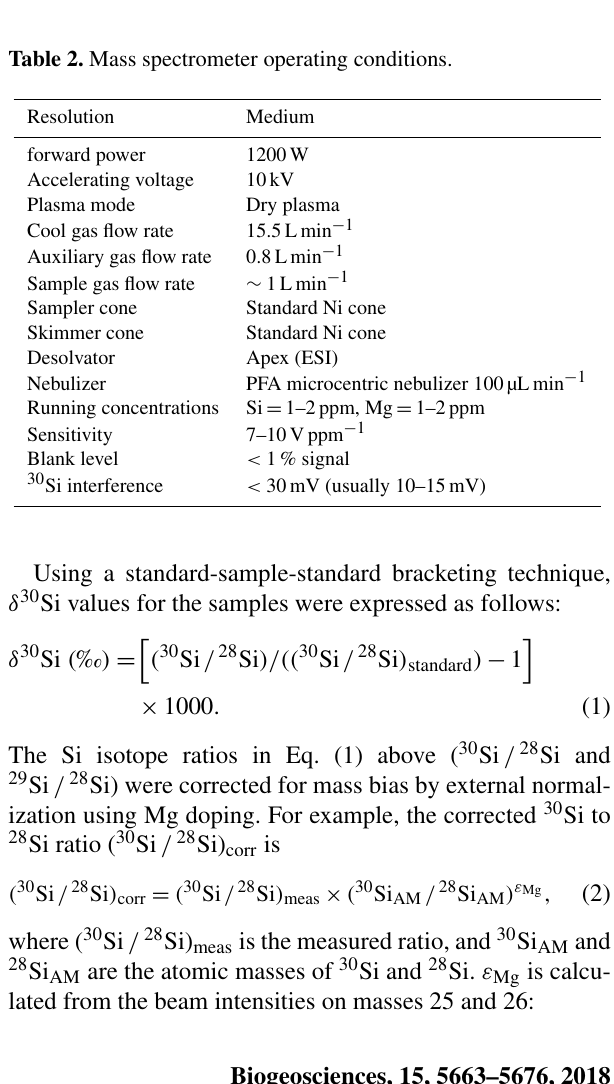
Figure 1. Map showing the sampling locations from the GEOVIDE voyage, overlain on a schematic of the intermediate and deep ocean circulation. Pink shading indicates the spreading of Labrador Sea Water (LSW) as documented by the extent of a water column minimum potential vorticity of 8 × 10 − 12 m − 1 s − 1 (McCartney, 1992). Dark blue arrows represent bottom-hugging Nordic Sea Overflows (ISOW and DSOW), pink arrows represent LSW, and orange arrows represent Lower Deep Water (McCartney, 1992; Dickson and Brown, 1994; Lambelet et al., 2016; see also García-Ibáñez et al., 2018).